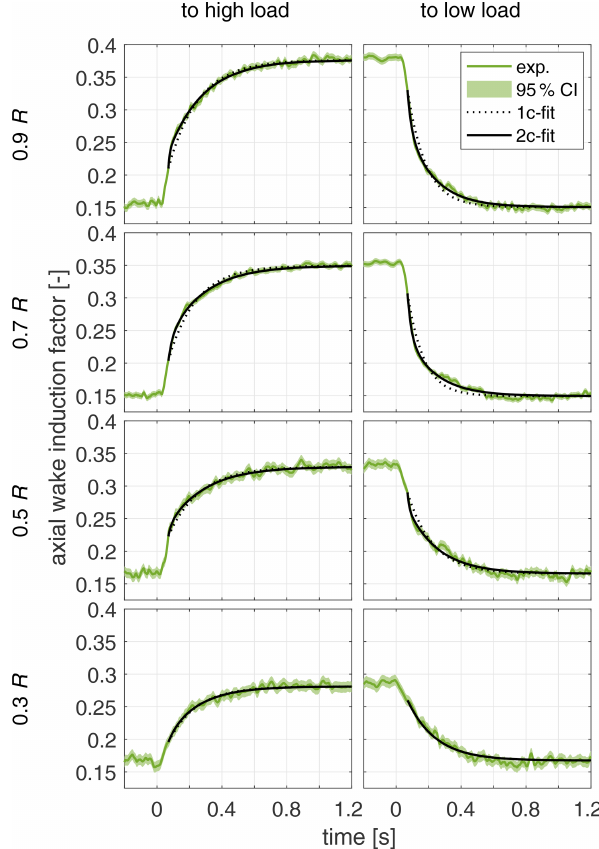
Figure 9. Axial wake induction factor over time for pitch step to high load and low load for the four radii 0.3, 0.5, 0.7 and 0.9 R and the fitted exponential decay models with one time constant (1c) and two time constants (2c).